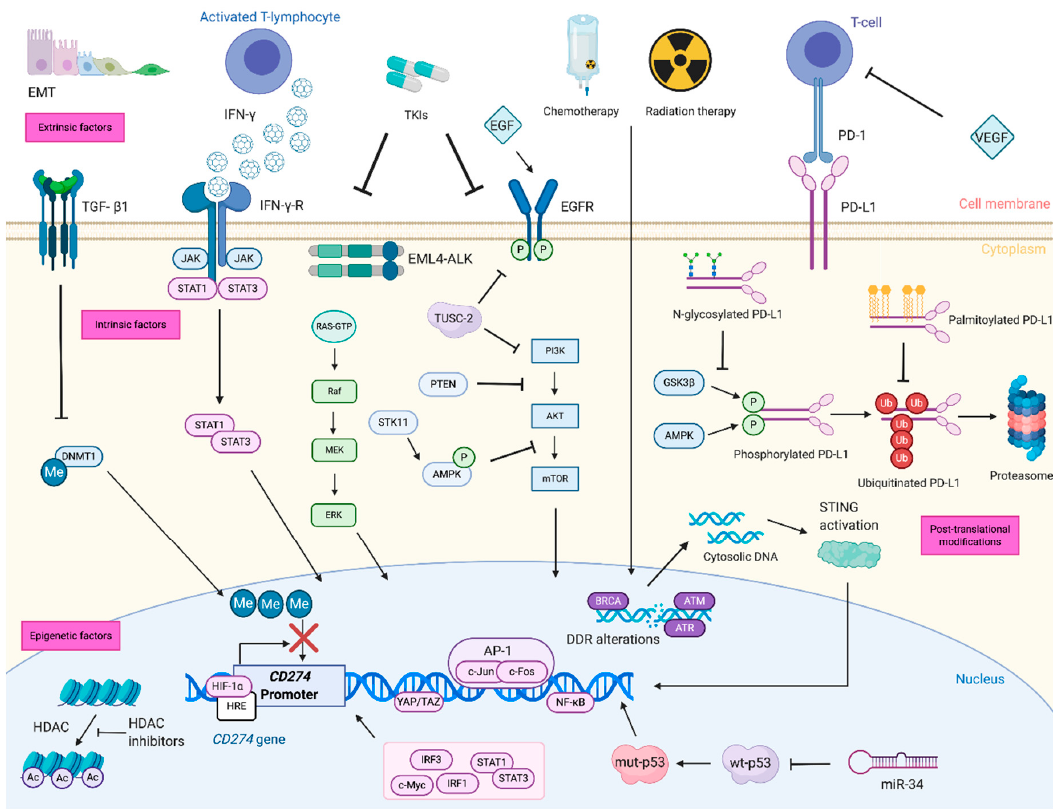
Figure 1. Regulation of PD-L1 expression involved several factors at different levels. The main extrinsic factors involved in PD-L1 regulation are pictured on the top of the picture and include cytokines (e.g., IFN- γ ), growth factors (e.g., EGF), hypoxia, chemotherapy, radiation therapy and TKIs, which regulate PD-L1 expression on the transcriptional level. Among intrinsic factors, genetic alterations, involve intracellular signaling pathways (e.g., MAPK, PI3K/Akt/mTOR, JAK/STAT), tumor suppressor genes (e.g., TP53 , STK11 ), DDR genes (e.g., BRCA1-2 , ATM , ATR ) and transcription factors (e.g., c-Myc, NF- κ B). Other intrinsic factors include epigenetic modifications: CD274 promoter methylation, inhibition of histone deacetylase and regulation of gene translation by miRNAs. The main post-translational modifications able to regulate PD-L1 stability and expression are phosphorylation, ubiquitination, glycosylation and palmitoylation (pictured on the right-hand side). Created with BioRender.com. EGF: Epidermal Growth Factor; EGFR: Epidermal Growth Factor receptor; EML4-ALK: echinoderm microtubule-associated protein-like 4 gene-anaplastic lymphoma kinase gene; IFN- γ : interferon-gamma; IFN- γ R: interferon-gamma receptor; TGF- β 1: tumor growth factor beta 1; TKIs: tyrosine kinase inhibitors; VEGF: vascular endothelial growth factor; PD-1: programmed-cell death; PD-L1: programmed-cell death ligand 1; TUSC2: tumor suppressor candidate 2; PI3K: phosphatidylinositol 3-kinase; Akt: Protein kinase B; mTOR: mammalian target of rapamycin; JAK: Janus kinase; STAT: signal transducer and activator of transcription; NF- κ B: nuclear factor kappa-light-chain-enhancer of activated B cells; TP53: Tumor protein p53; STK11 : Serine /